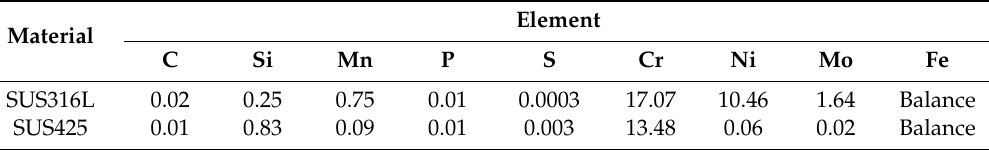
Table 1. Chemical composition of base metals (wt %).